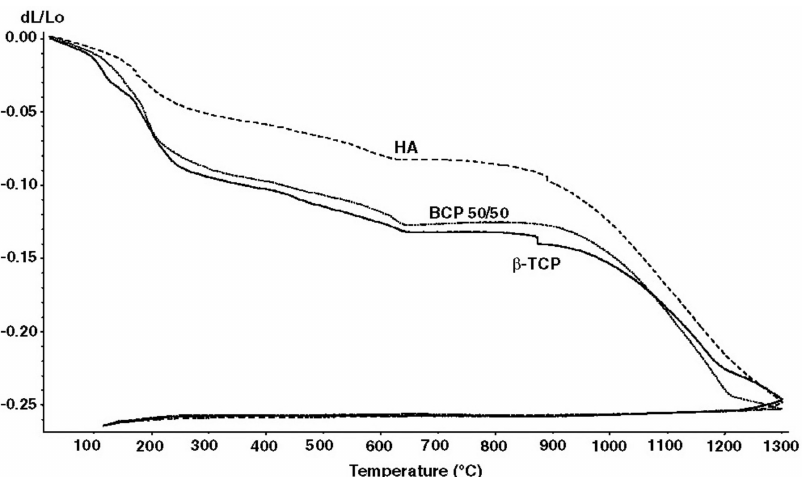
Figure 5. Linear shrinkage of the compacted ACP powders that were converted into β -TCP, BCP (50% HA + 50% β -TCP), and HA upon heating. According to the authors: “At 1300 ◦ C, the shrink- age reached a maximum of approximately ~25, ~30 and ~35% for the compacted ACP powders that converted into HA, BCP 50/50 and β -TCP, respectively” [258]. Reprinted from Ref. [258] with